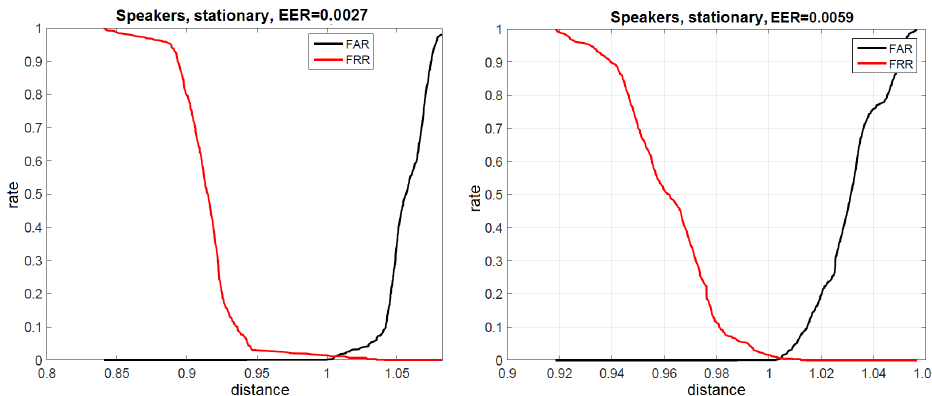
Figure 30. FAR–FRR diagram for results of off-line (Left Drawing) and on-line (Right Drawing) speaker recognition tests (11 speakers) with stationary